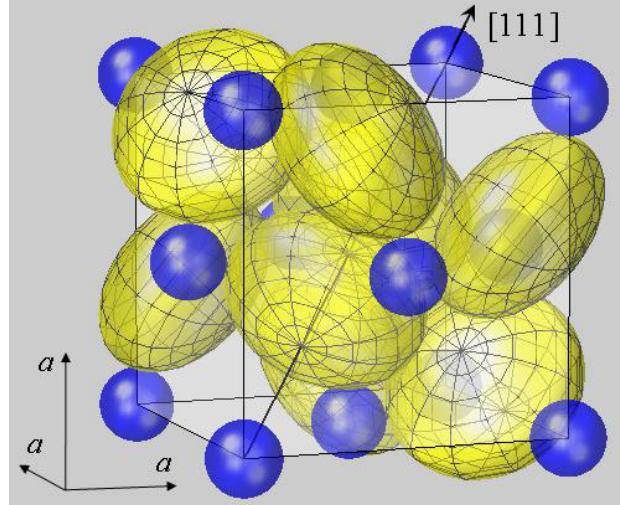
Figure 3. A new look at the pyrite structure: crystallographic unit cell of pyrite FeS Fe and S ions modelled by spheres and ellipsoids, respectively. Radial parameters r Fe 2+ and r and for S − were used as given for FeS ||